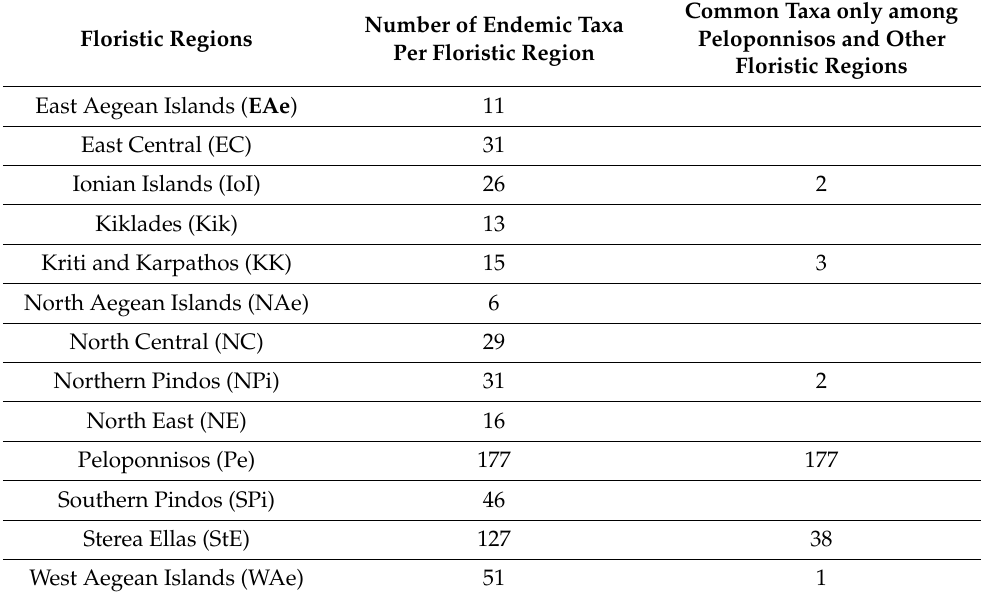
Table 1. Distribution of Greek endemic taxa of CVNP in floristic regions of Greece. Common Taxa only among Number of Endemic Taxa Peloponnisos and Other Floristic Regions Per Floristic Region Floristic Regions East Aegean Islands ( EAe ) 11 East Central (EC) 31 Ionian Islands (IoI) 26